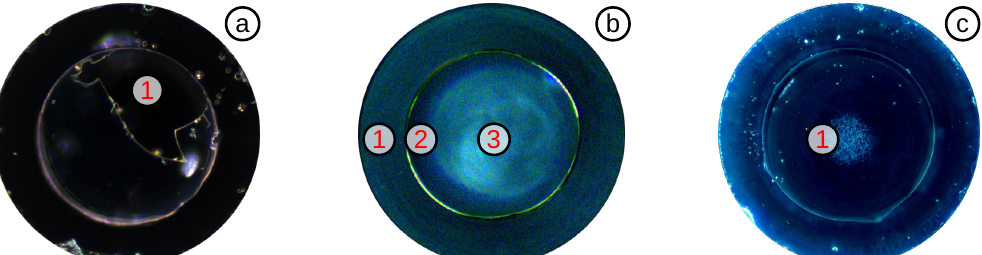
Figure 11. Top-view of: ( a ) a diaphragm with a big hole (1) caused by over-etching; ( b ) clean 2–3 µ m-thick diaphragm with: (1) CAP; (2) cavity and (3) SMF; ( c ) long-term used sensor, with small accumulated glass particles (1).